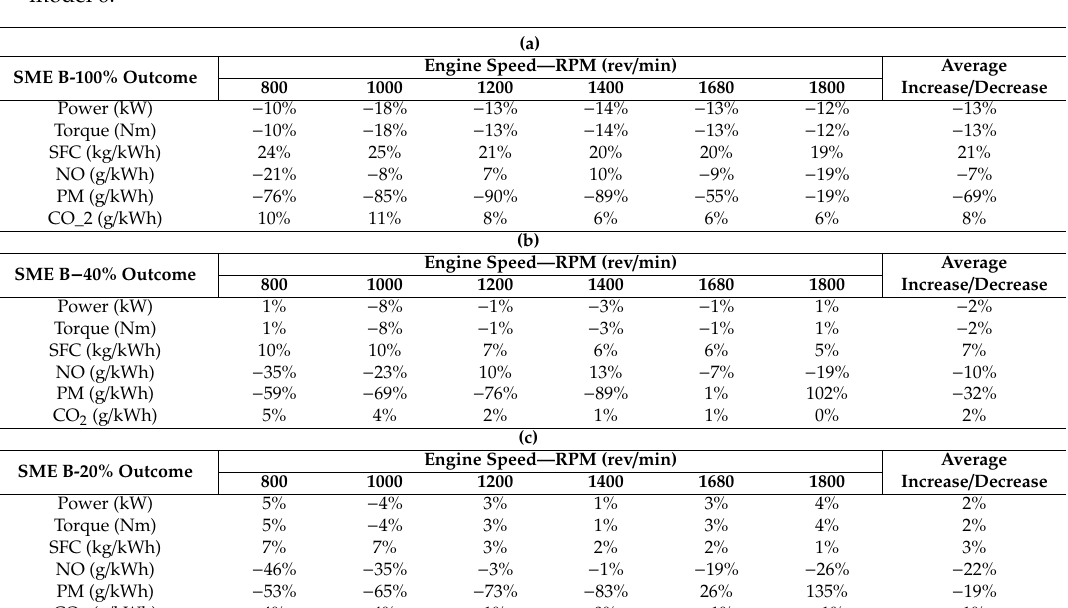
Table 8. Outcomes of the engine operating on three di ff erent types of biodiesel blends applied to MC model